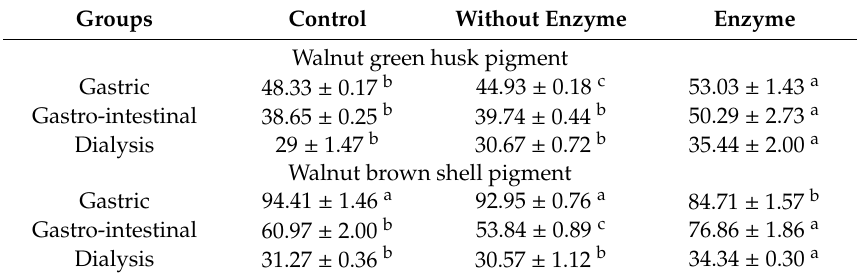
Table 3. The total reducing power (RP) of walnut green husk and brown shell pigment subjected to simulated in vitro digestion and dialysis ( µ mol TE / L).